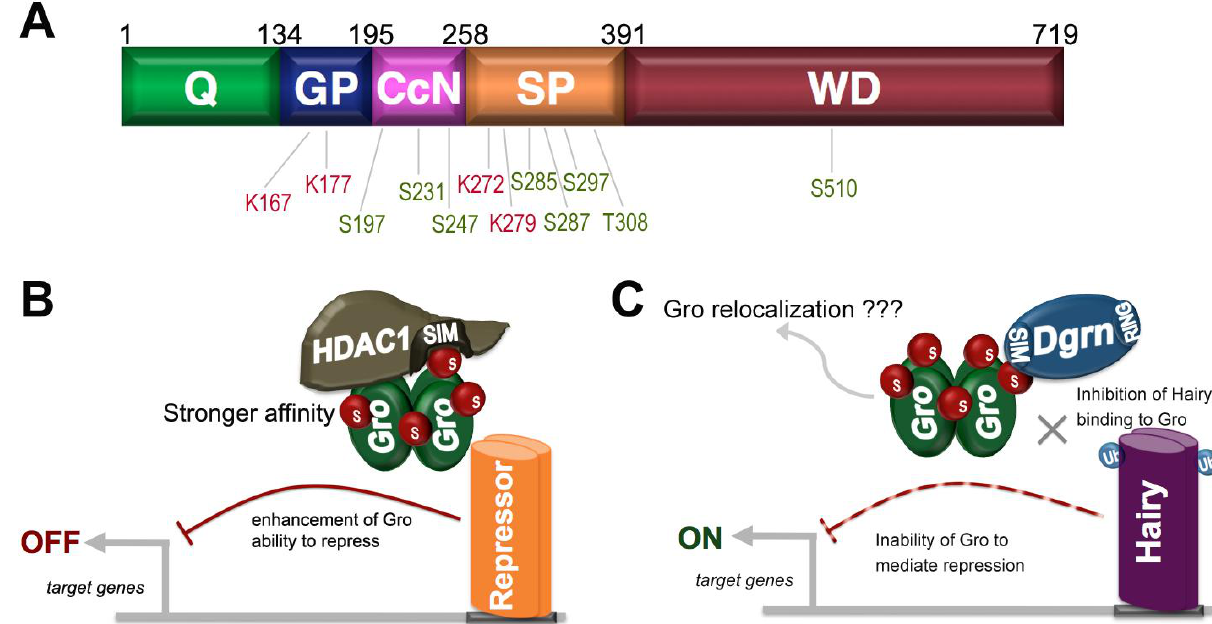
Figure 4. The role of SUMOylation in Groucho (Gro)-mediated repression. ( A ) Gro consists of five domains (the Q, GP, CcN, SP, and WD-repeat domains). Known SUMO acceptor residues are shown in red, while known phospho-acceptor residues are shown in green; ( B ) Proposed mechanism by which SUMOylation of Gro enhances its ability to repress by increasing its affinity for a SUMO interaction motif (SIM) in HDAC1; ( C ) Proposed mechanism by which SUMOylation of Gro inhibits Gro-mediated repression through an inhibitory interaction between sumoylated Gro and a SIM in the SUMO- targeted ubiquitin ligase Dgrn. This interaction may lead to relocalization of Gro to a cellular compartment where it is inactive. Dgrn may also direct ubiquitylation of the Gro- dependent repressor Hairy, inhibiting Hairy’s ability to interact with Gro, thus further relieving the repression of a subset of Gro